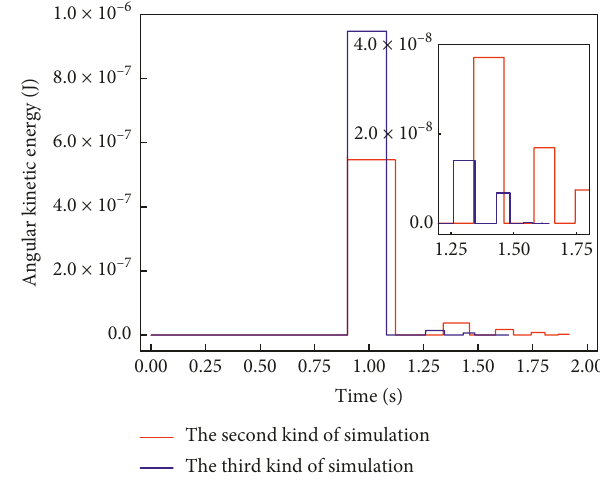
Figure 14: Kinetic energy.